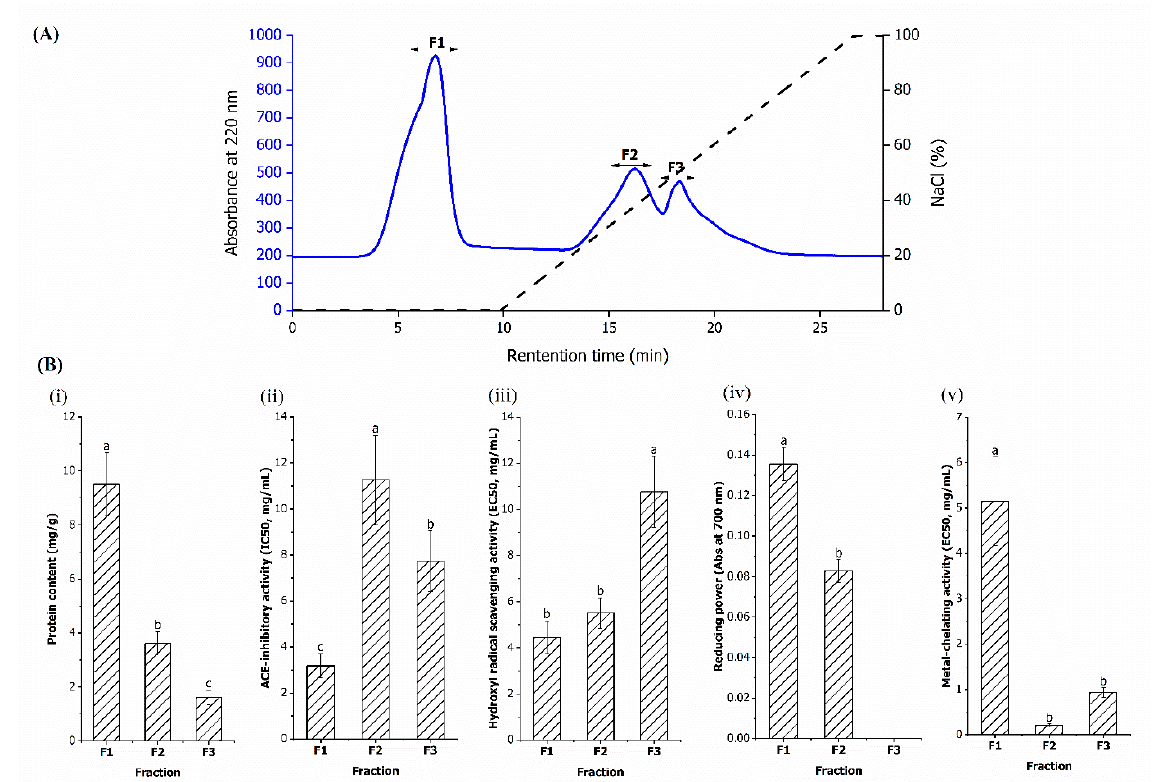
Figure 3. ( A ) The elution profile of HB-IV fraction separated by anion exchange chromatography on a QFF column. ( B ) The protein content and bioactivities of each collected fractions (F1–F3). The values represent the mean ± SD. Mean without a common letter (a–c) on the bars indicate significant difference at p < 0.05.